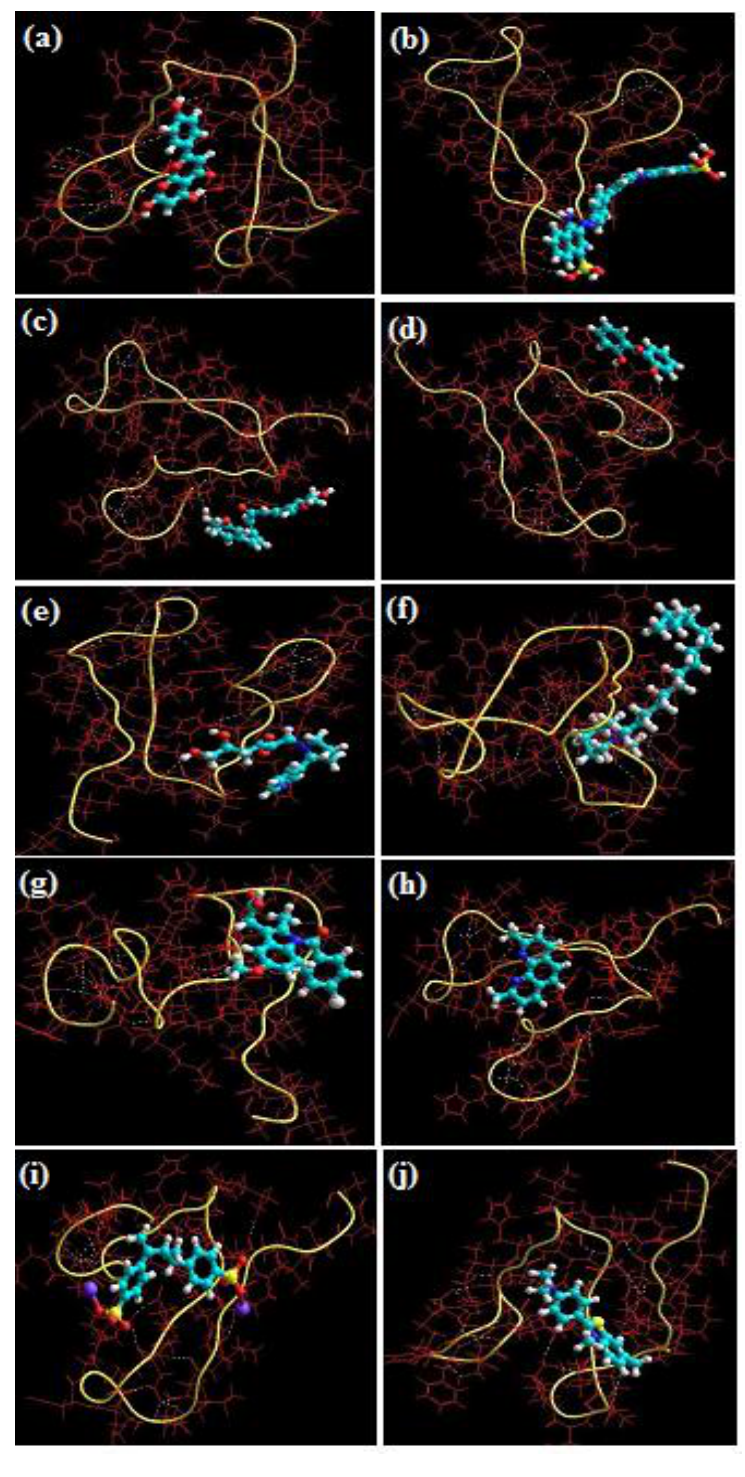
Figure 2. Energy minimized geometrical preferences of the protein-NE complexes derived from Molecular Mechanics computations: ( a ) apigenin; ( b ) congo red; ( c ) curcumin; ( d ) dihydroxybenzophenone; ( e ) glycosylated nornicotine; ( f ) hexadecylmethylpiperidinium; ( g ) indomethacin; ( h ) neocuproine; ( i ) polystyrene sulfonate and ( j ) thioflavin